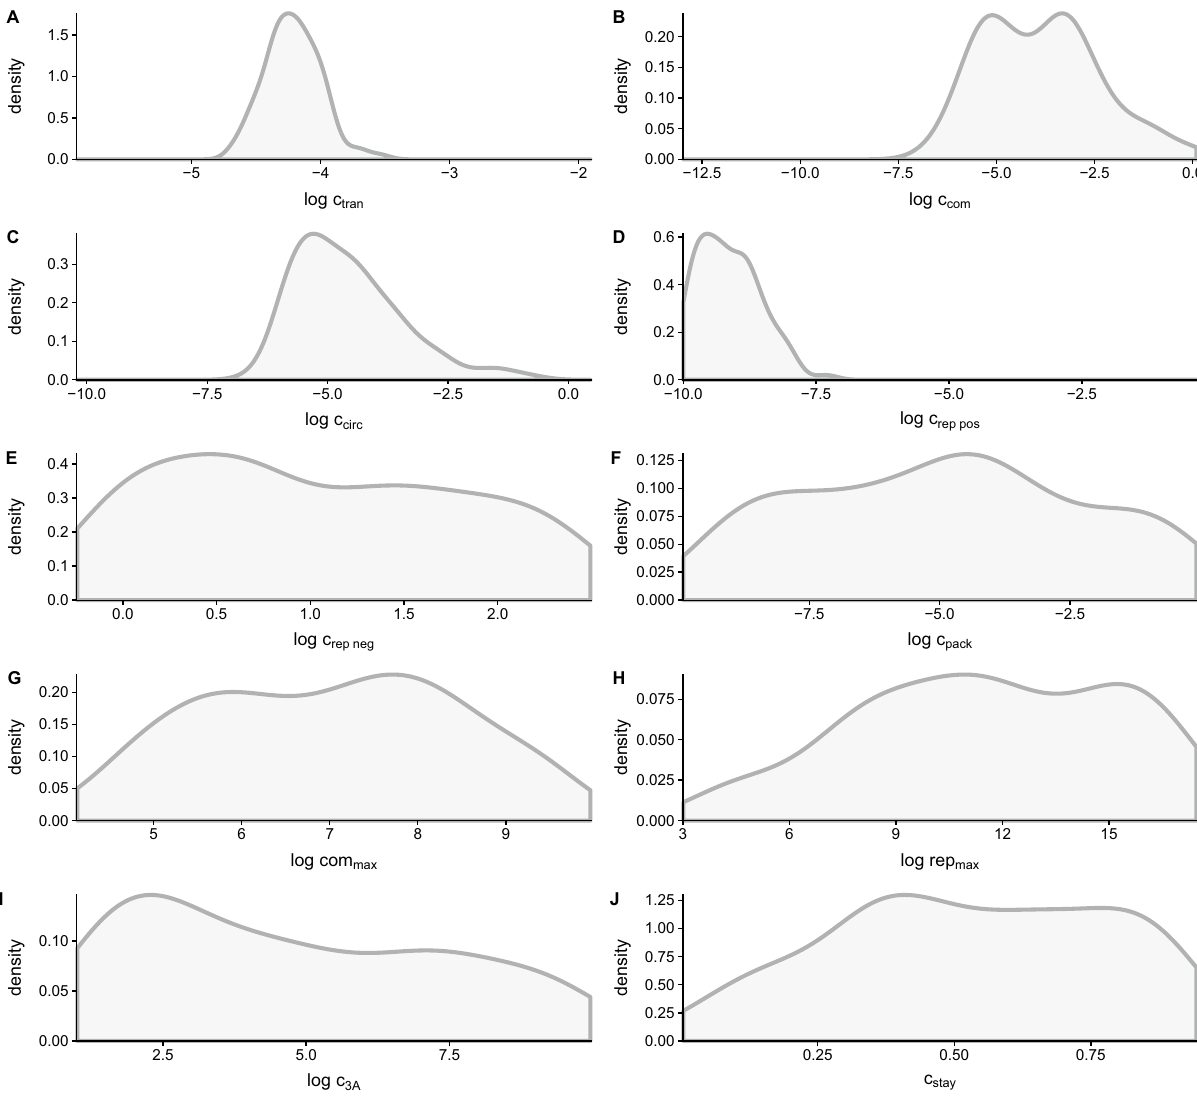
Figure 4. Estimates of mechanistic parameter posterior distributions in our model of PV infection from fitting the model to experimental data generated without drug treatment (Fig. 1C–F). Parameters are estimated by fitting the model described by the equations in Table 1 and illustrated in Fig. 2A. The parameters shown correspond to those labeled in each reaction. ( A ) Translation, which occurs in step 3 of the model. ( B ) Compartmentalization, a part of step 4. ( C ) Circularization, step 5. ( D , E ) Replication of positive and negative sense RNA, step 6. ( F ) Packaging, step 7. ( G ) The maximum number of compartments possible, considered